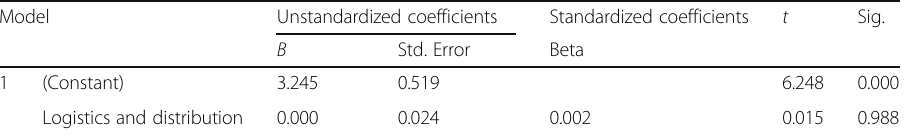
Table 18 Regression coefficients Model Unstandardized